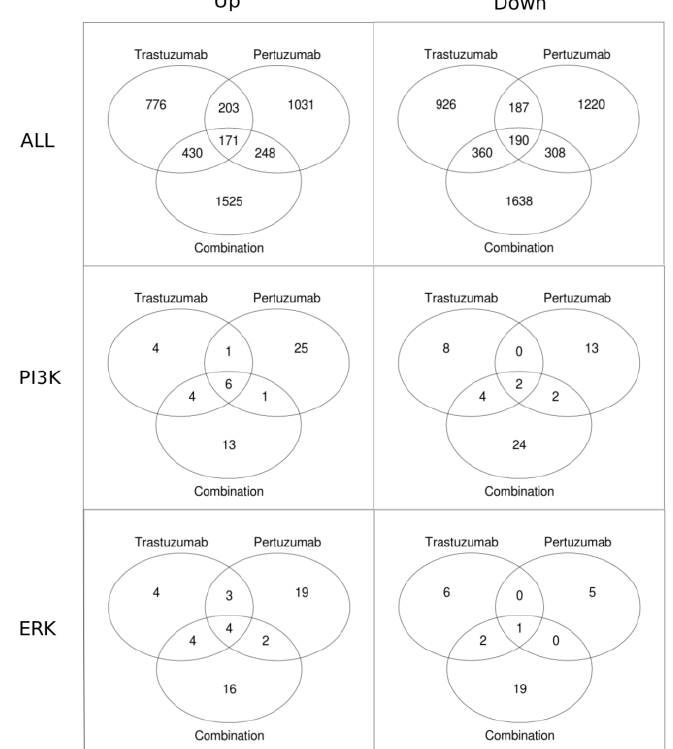
Figure 9. Venn diagrams showing the numbers of genes with statistically significant fold change in trastuzumab, pertuzumab, and their combination treatments of SKOV3 ovarian xenograft tumour [28]. The first row of the figures contains all the genes up-regulated (left column) and down-regulated (right column). The second and the third rows show Venn diagrams for the genes associated with the PI3K/AKT and ERK1/2 pathways,